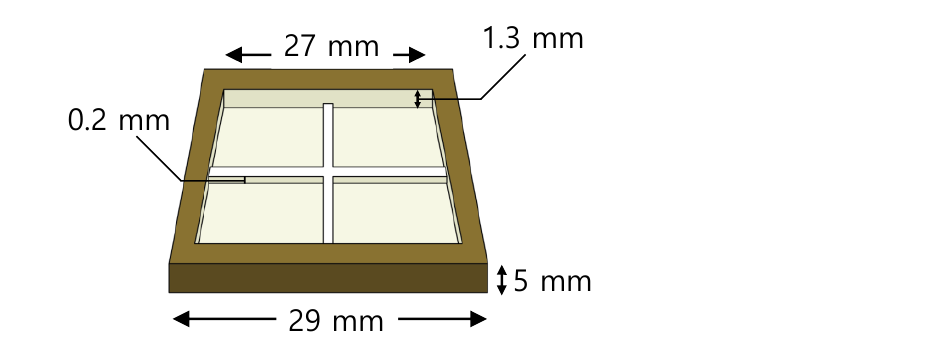
Figure 4. Schematic of jig for compression molding.